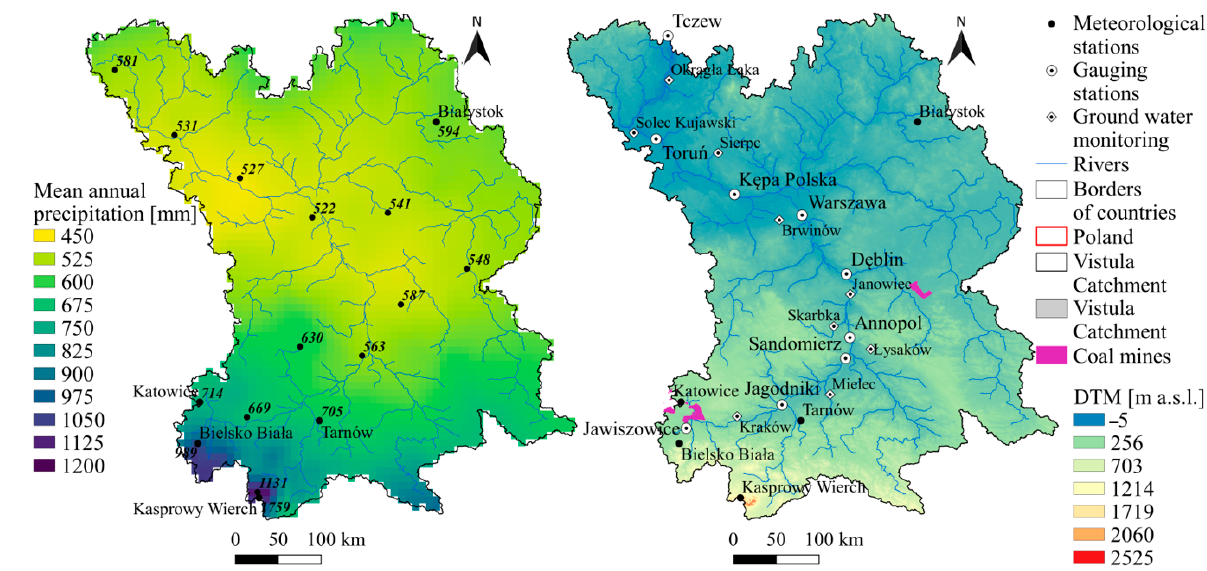
Figure 2. Spatial distribution of mean annual precipitation in the catchment based on E-OBS 20.0e data [22] and data from meteorological stations for the period 1951–2019 ( left panel ) and location of hydrological gauging stations and groundwater monitoring points along the course of the Vistula River ( right panel ). Table 1. Precipitation characteristics in selected meteorological stations.